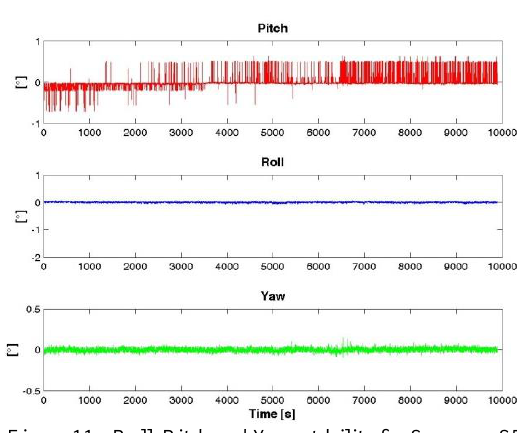
Figure 10 - Gyroscope residuals for Samsung Galaxy S5